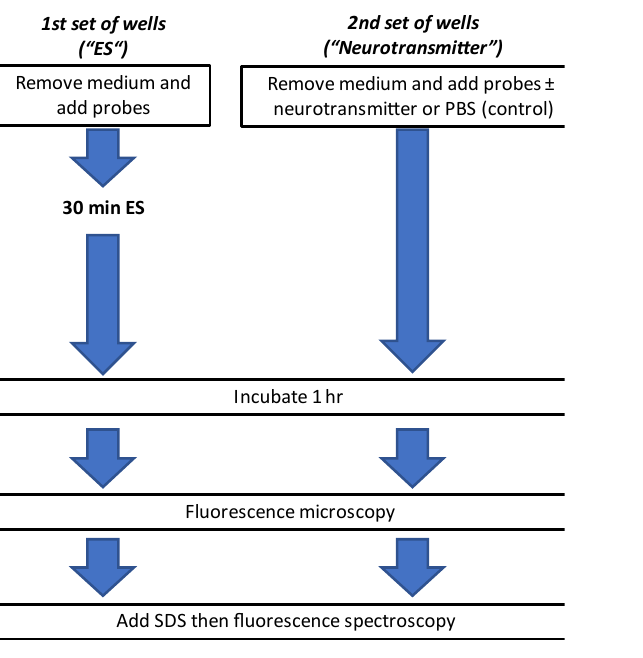
Figure 2. Experimental design introducing both MQAE and DAF-FM or Fluo4-Am as probe with and without neurotransmitter co-incubation. ES: electrical stimulation; PBS: phosphate buffered saline; SDS: sulfate dodecyl sodium.